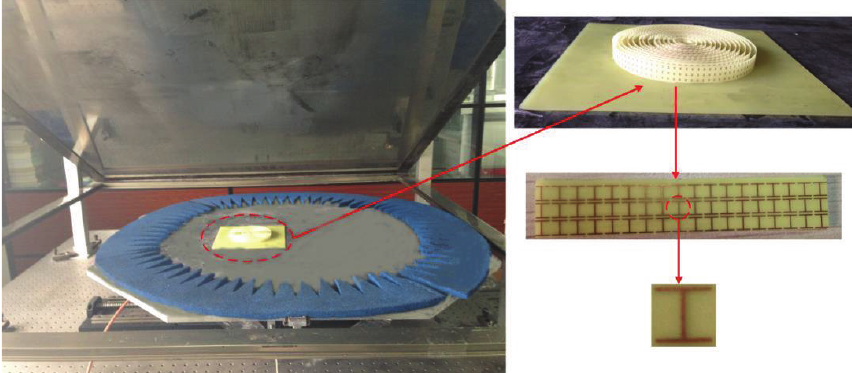
Figure 5: The experimental setup of the modified Luneburg lens, where the inset shows the details of the sample.